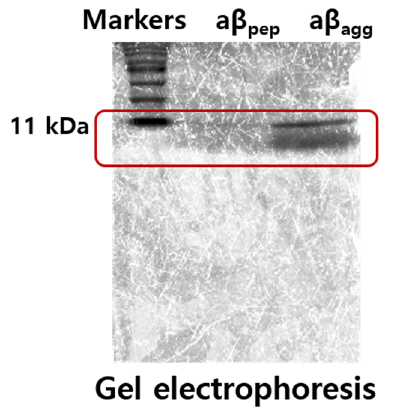
Figure 6. Gel electrophoresis results of a β pep and a β agg .